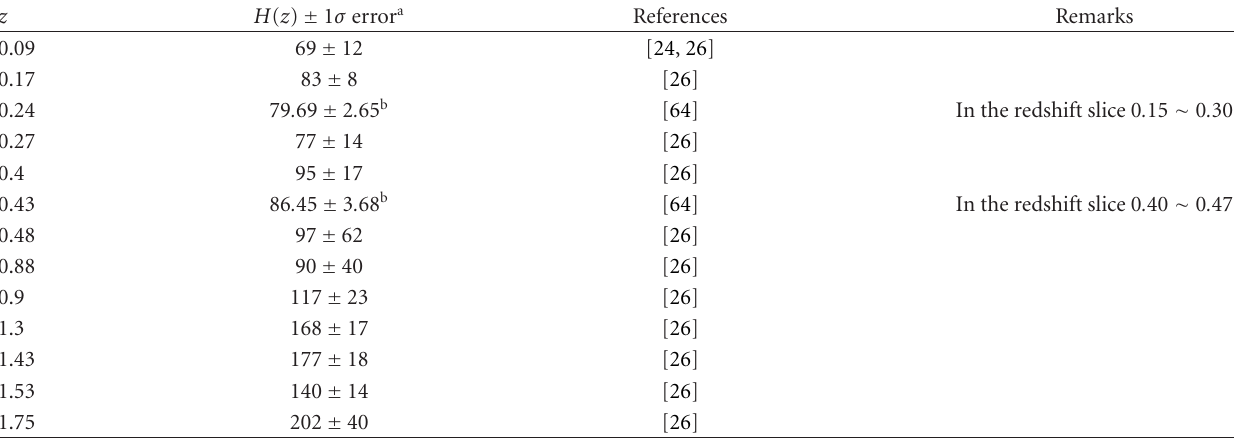
Table 1: The set of available observational H ( z ) data.